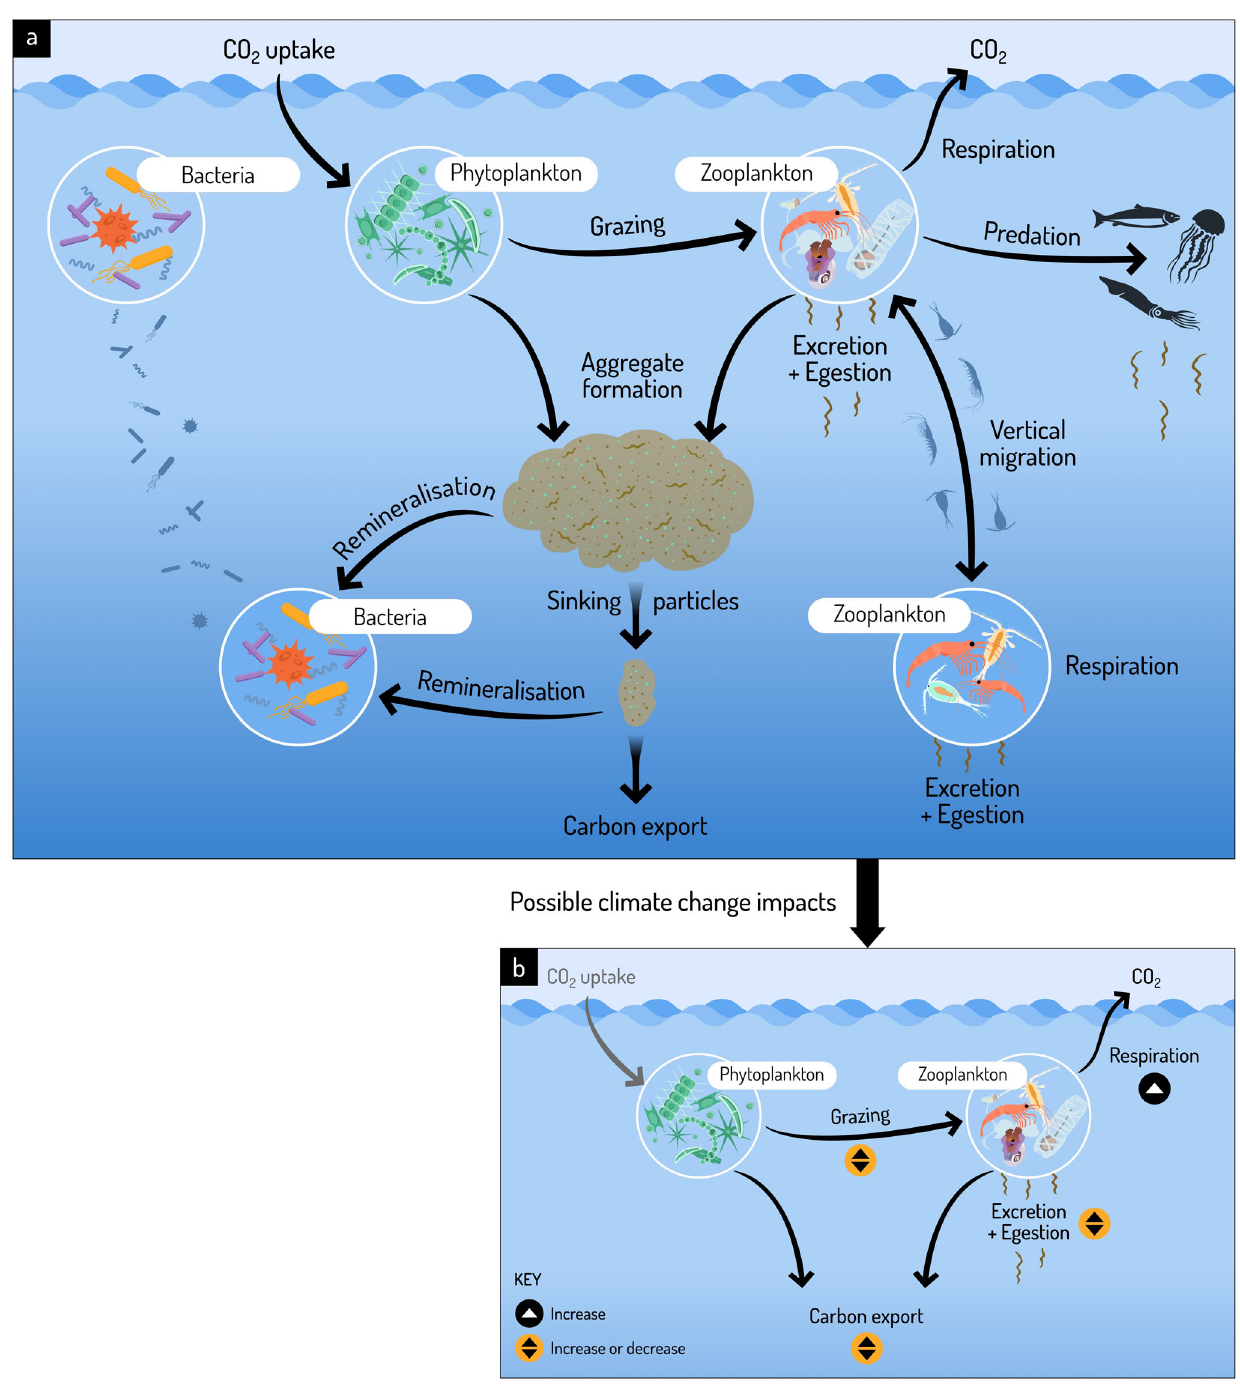
Fig.2|Theroleofzooplanktonwithinthebiologicalcarbonpumpandpossible climate-driven impacts on key zooplankton processes. a Zooplankton graze on phytoplankton, transferring carbonand nutrients.Excessnutrientsinzooplankton are recycled via excretion and egestion either within the upper ocean or throughout the entire water column as some zooplankton undertake diel vertical migration. Unconsumed phytoplankton form aggregates, and together with zoo- plankton faecal pellets, these particles rapidly sink and are exported to deeper waters. However, bacteria remineralise much of these sinking particles along its